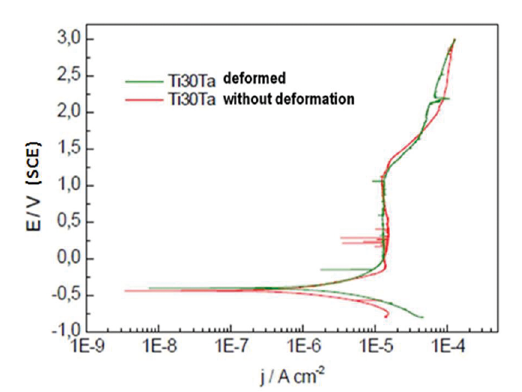
Figure 3. Polarization curves for Ti30Ta alloy in NaCl 0.15M + NaF 0.03M solution